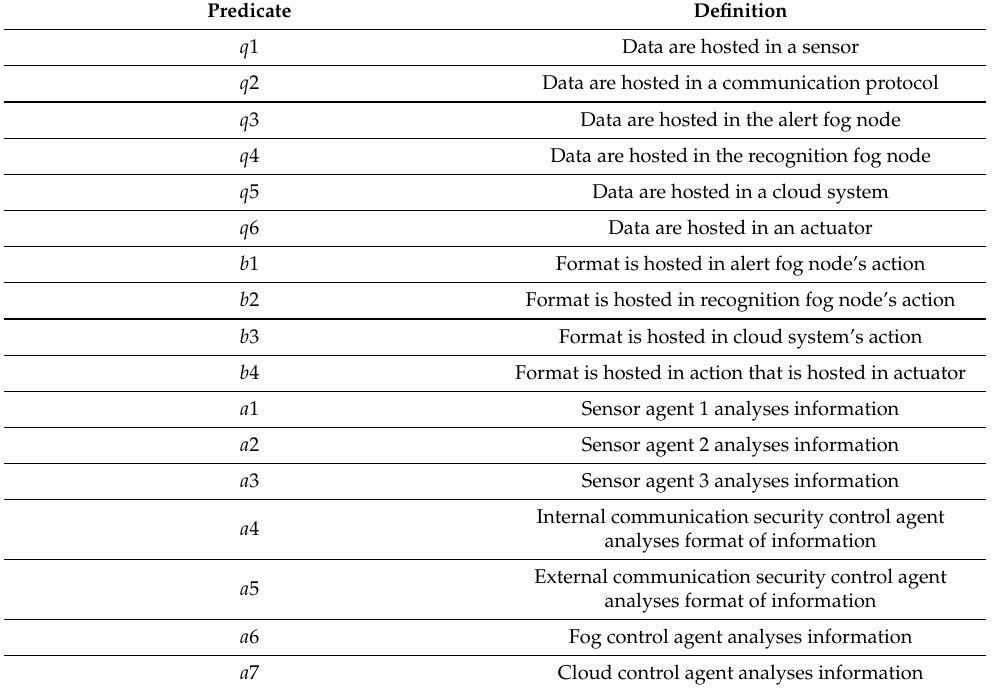
Table 10. Predicates definition